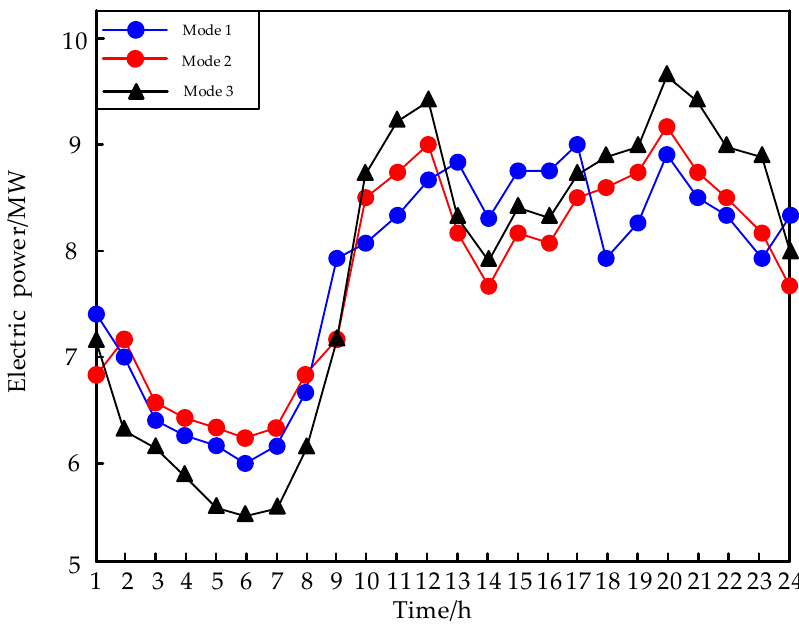
Figure 15. Power output curve under different electricity price.